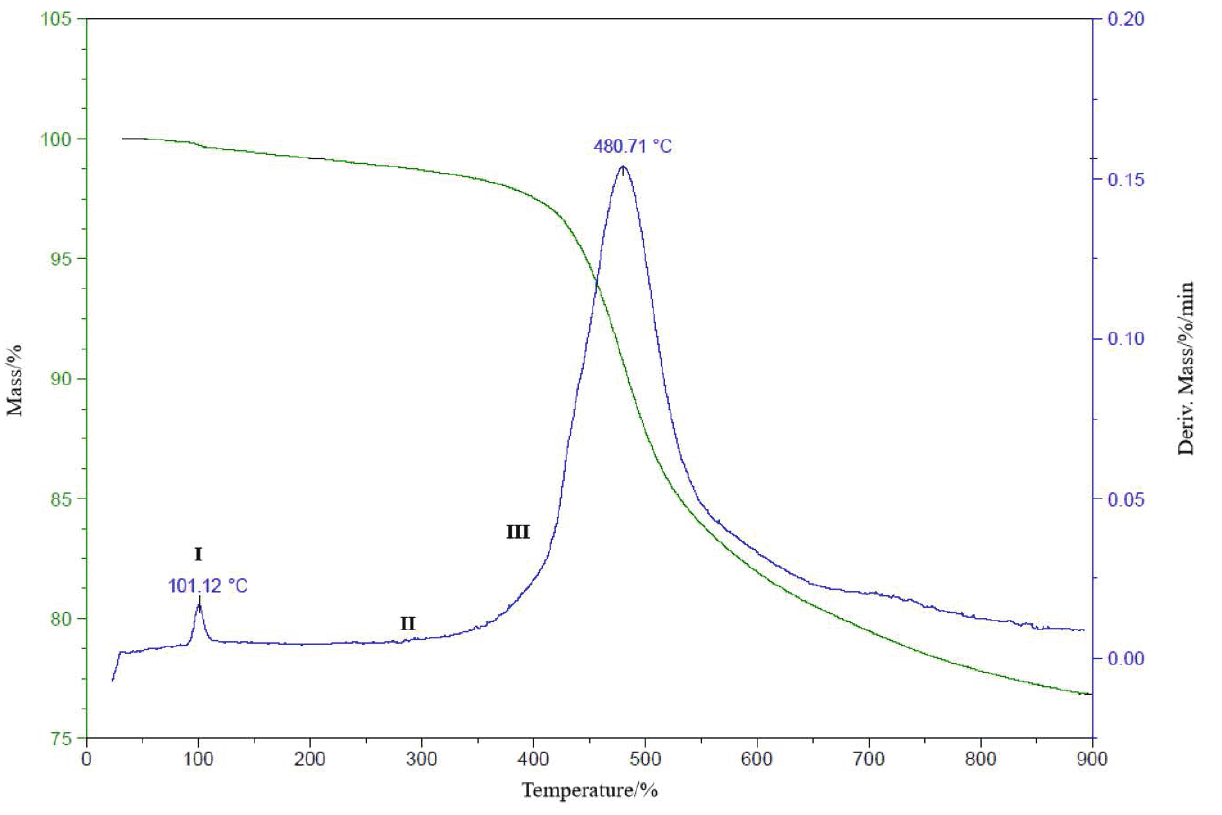
Fig. 4 – TG-DTG curves of Moatize coal measured at 10 ºC min –1 in a nitrogen